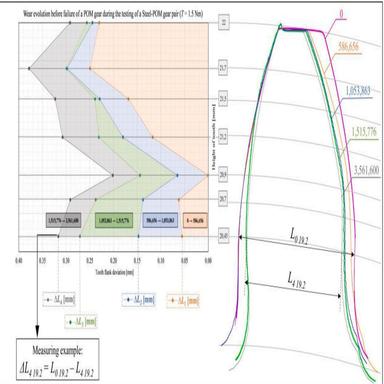
Worn POM gear tooth profiles (right) and wear distribution over the flank (left).